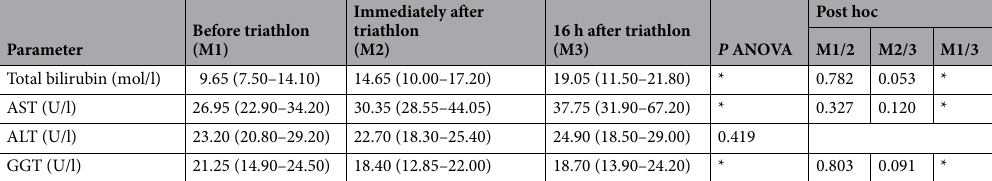
Table 8. Medians (IQR) of liver function indicators in the 3 performed measurements (M). *Significant difference ( P < 0.05). IQR interquartile range, AST aspartate transaminase, ALT alanine transaminase, GGT gamma-glutamyltransferase.